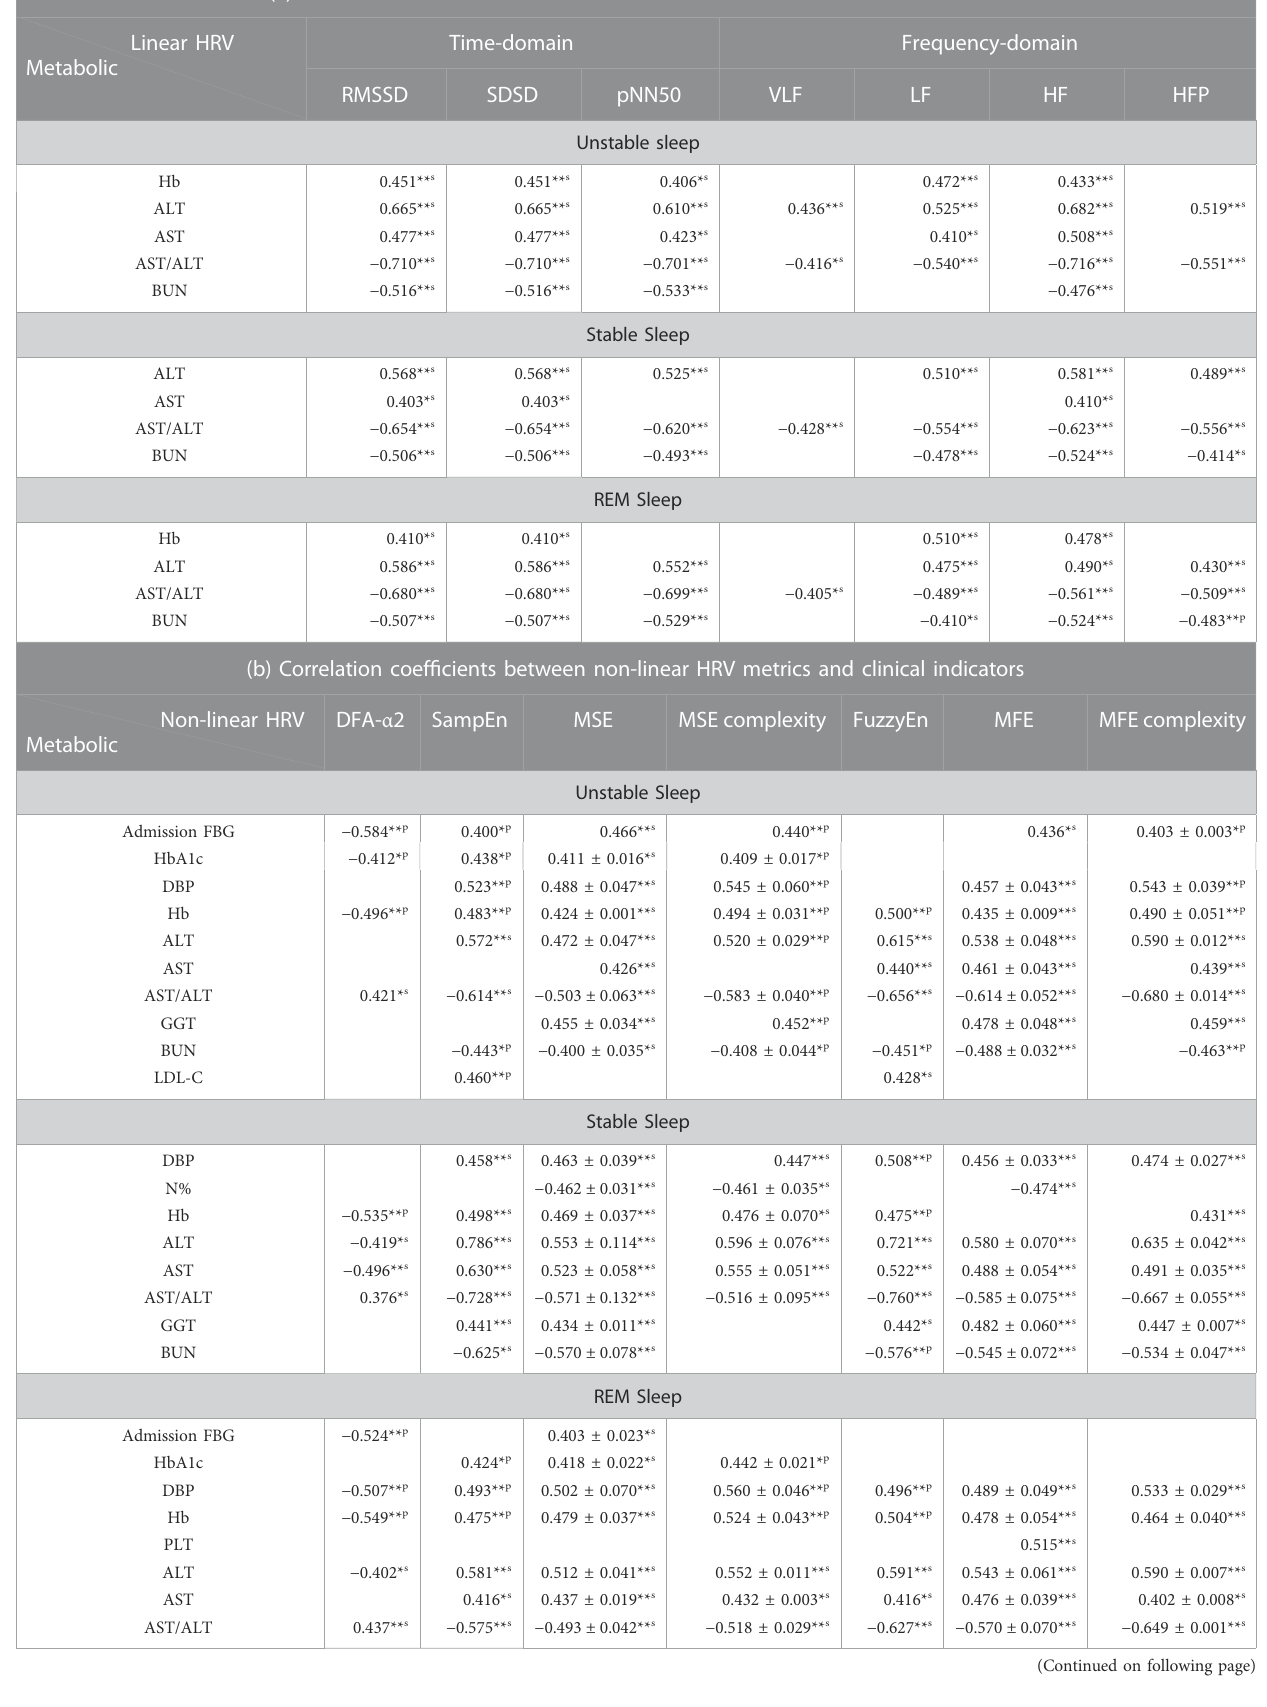
TABLE 6 Correlation coef fi cients between HRV metrics in three sleep stages and clinical indicators. (a) Correlation coef fi cients between linear HRV metrics and clinical indicators